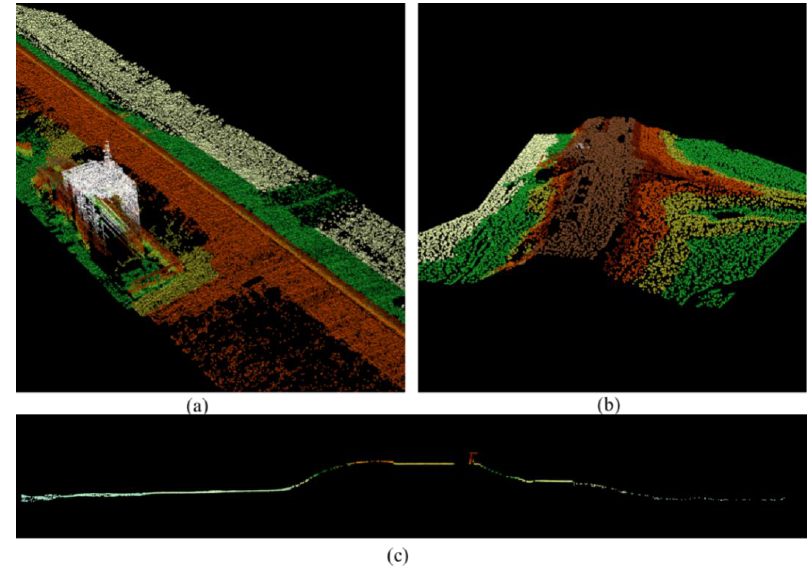
Figure 6. Detail point cloud: ( a ) tide gauge station; ( b ) southern end of the dam; ( c ) cross section of the dam in the middle section cut from point cloud.